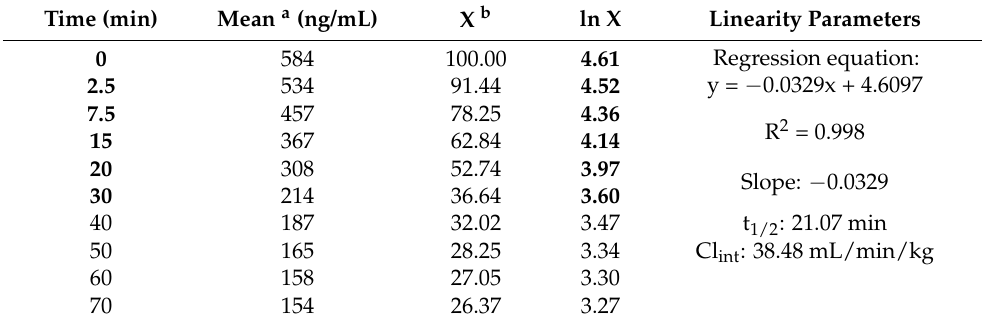
Figure 5. The STP metabolic stability curve in HLMs ( A ) and ln calibration curve showing the regression equation ( B ). Table 5. STP metabolic